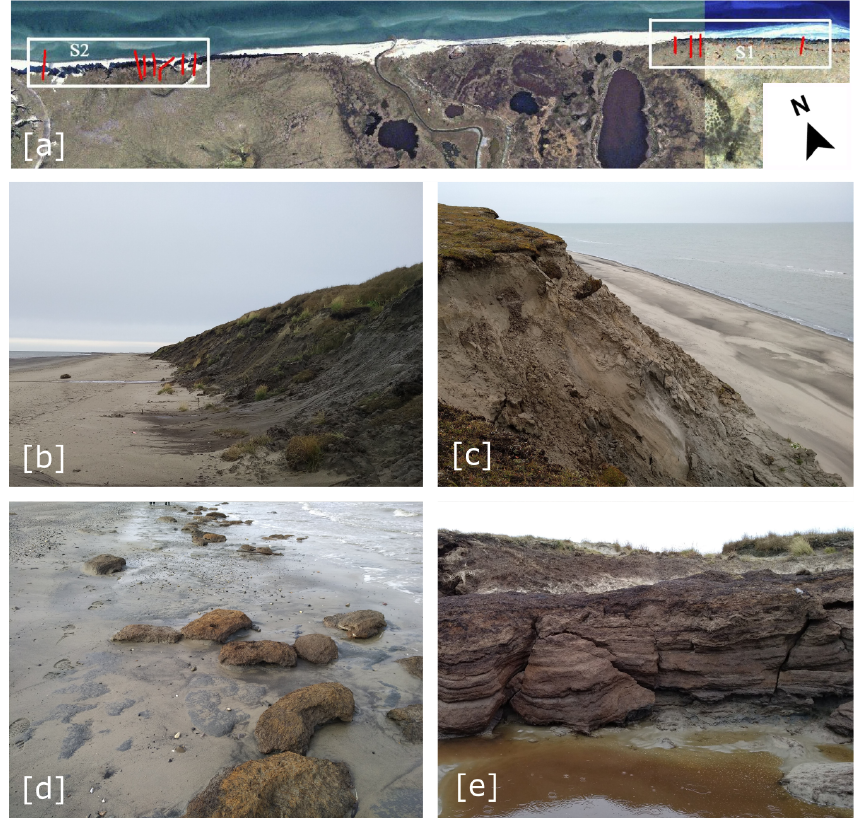
Figure 2. ( a ) Beach profile lines in zone S1 and zone S2 (thick red lines) from the surface of the bluff to the swash zone of the beach. ( b ) Bluff in zone S1 and ( c ) bluff in zone S2. Zone S1 has an uneven bluff surface, a relatively gentle bluff slope and a wide and smooth beach (subfigure ( b )), whereas zone S2 comprises a steeper bluff slope and a narrower beach (subfigure ( c )). ( d ) Remnant of an earlier collapsed bluff. Sizes of the collapsed bluff are not big enough to disrupt storm surge and to prohibit the growth of niche at the base of bluffs. However, the active layer with dead vegetation still resists degradation, whereas the rest of the collapsed bluff